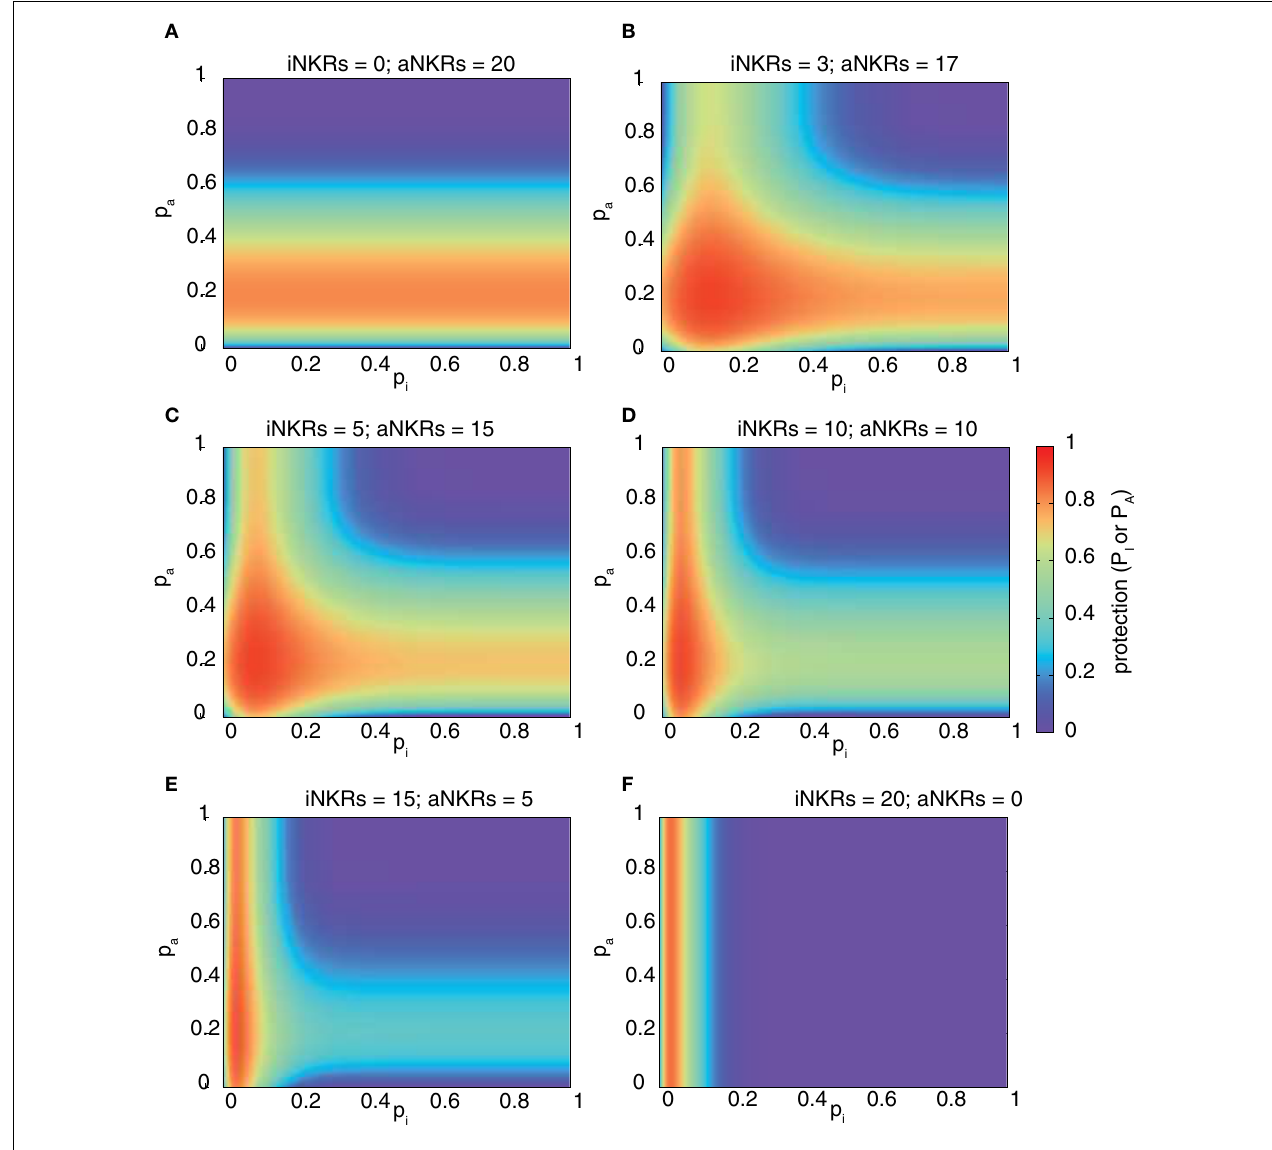
of iNKR and aNKR. Considering a haplotype size of N NKR = 20, we first modeled haplotypes composed of aNKRs only (A) , and reduced their number, while increasing the number of iNKRs (B–E) , until we obtained a haplotype composed only of iNKRs (F) .We here consider 2 MHC loci (i.e., N MHC =